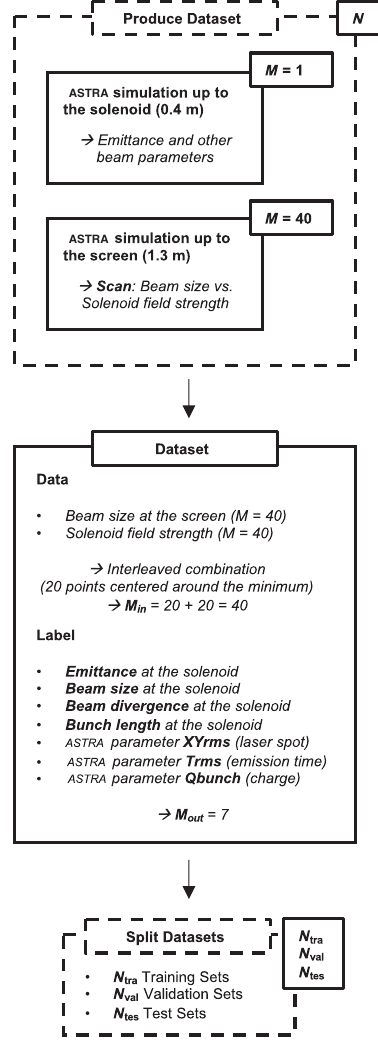
FIG. 3. Diagram showing how the FCNN training, validation, and test data is produced. N is the total number of datasets. M is the number of ASTRA simulations. M is the final number of data in points to be fed to the FCNN. M is the length of the output out vector, i.e., the number of predicted beam and simulation parameters. The datasets are split into three categories, where 0 . 6 · N , N 0 . 2 · N in this study, the common split of N tra ¼ val ¼ 0 . 2 · N is and N tes ¼